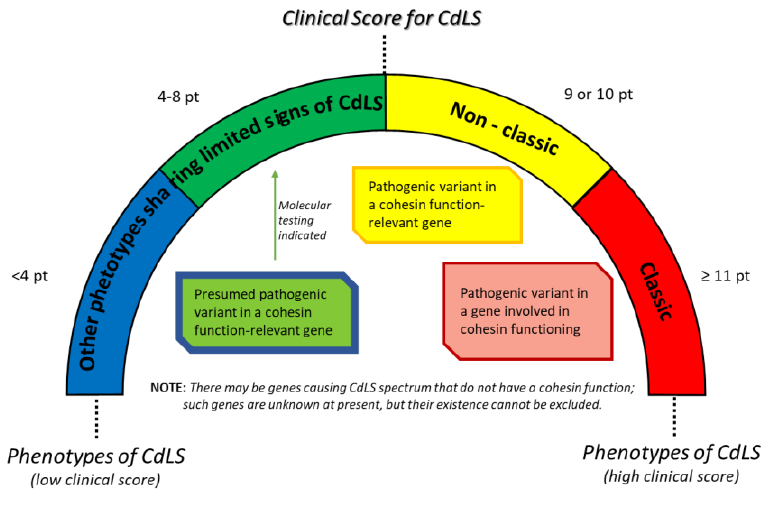
Figure 1. The rainbow phenotypes of Cornelia de Lange Syndrome (CdLS) [2].